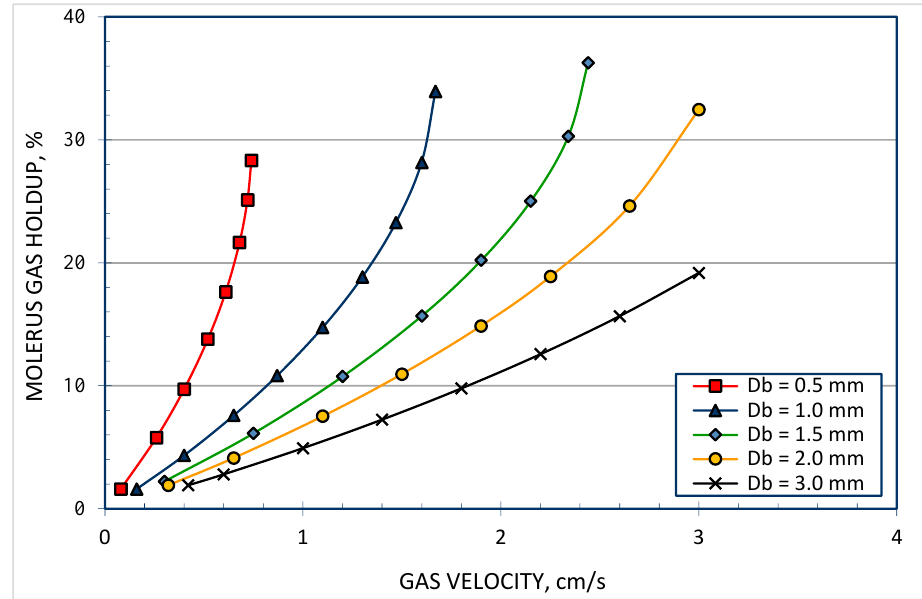
Figure 2. Gas holdup predictions for selected bubble sizes and gas velocities (Molerus model).